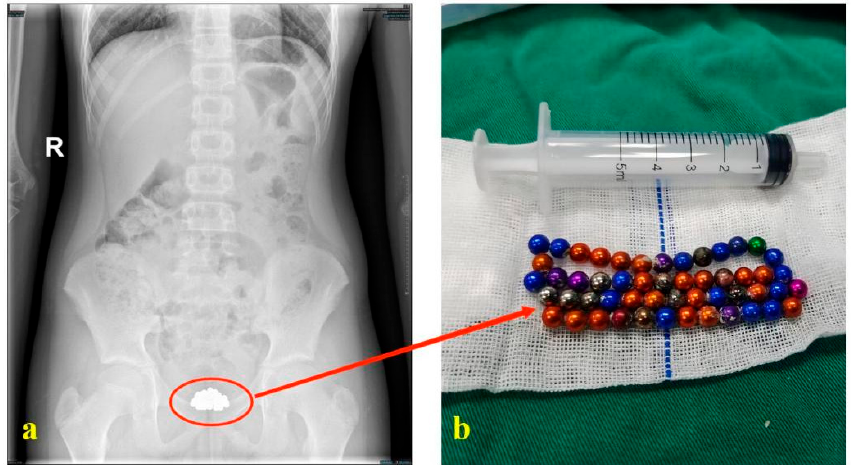
Figure 5. Preoperative examination and postoperative physical picture of magnetic beads. (( a ): Preoperative X-ray examination of the patient; ( b ): Magnetic beads removed after surgery).